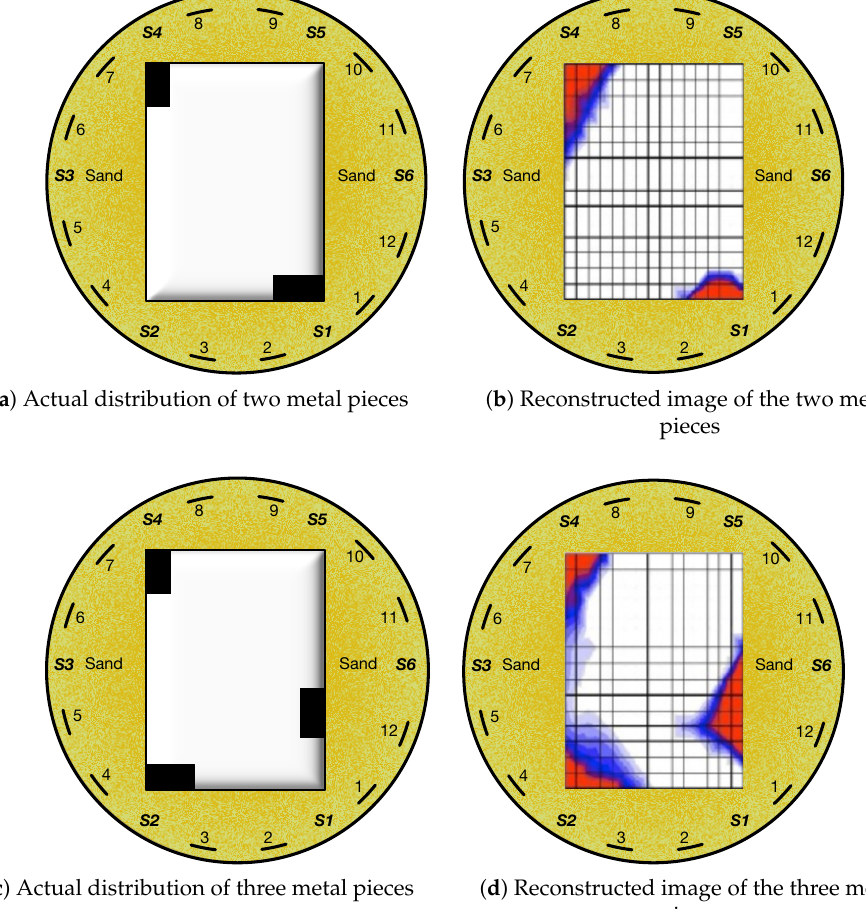
Figure 6. Actual metal distribution and reconstructed tomographic images for different metal objects using an ILBP